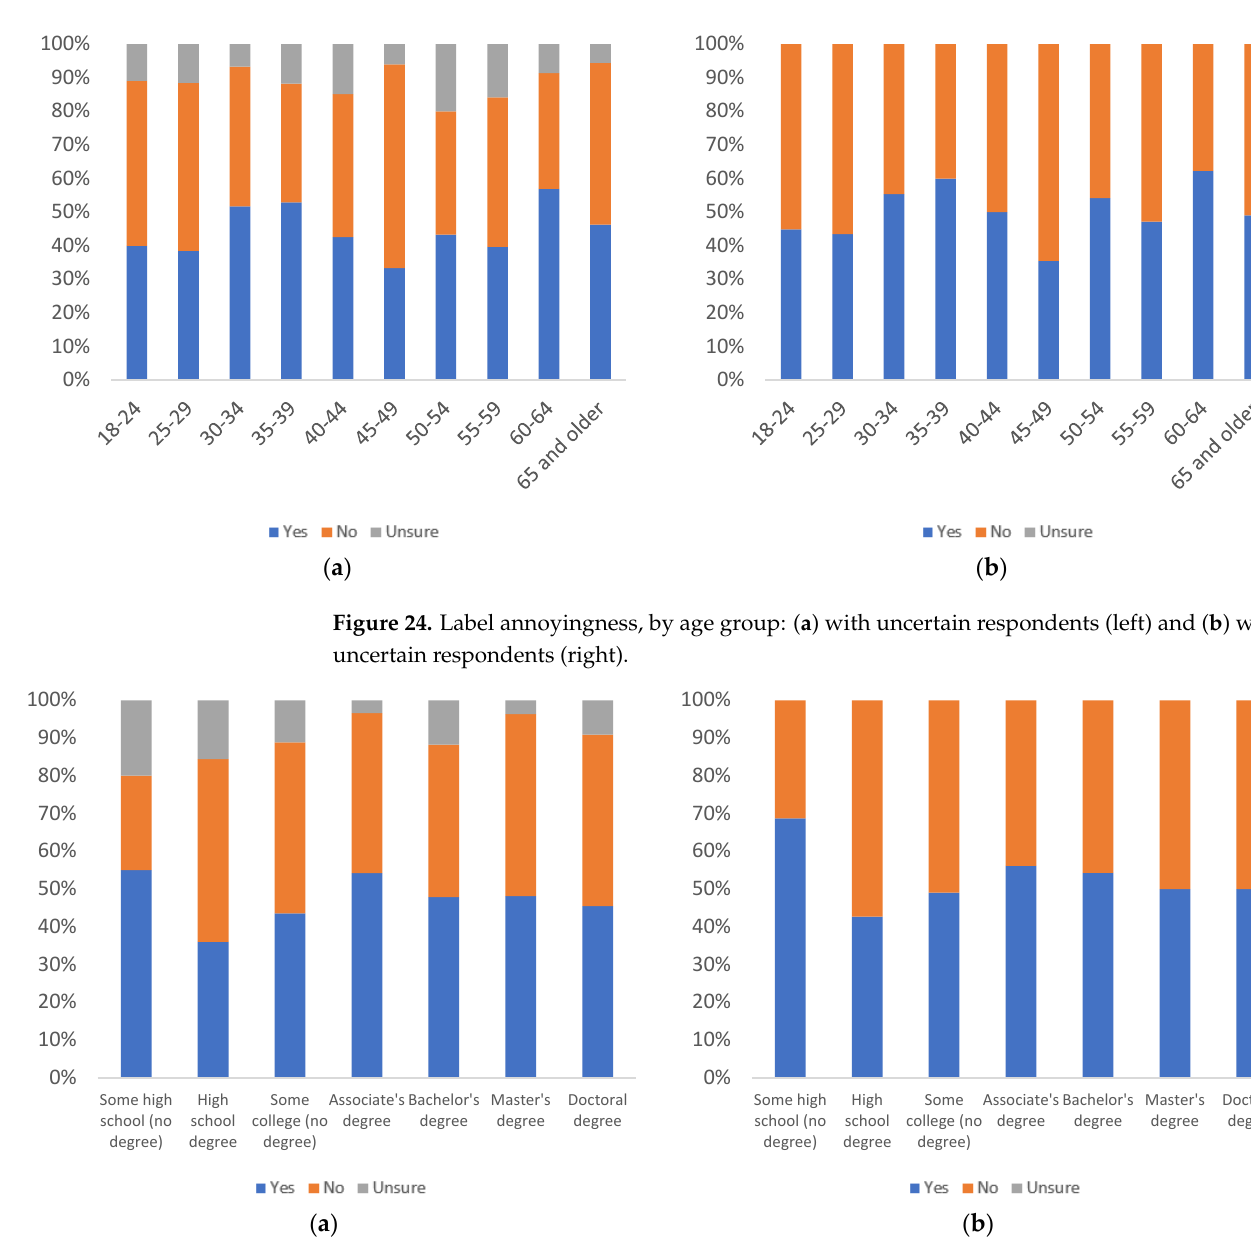
Figure 25. Label annoyingness, by education level: ( a ) with uncertain respondents (left) and ( b ) without uncertain respondents (right).